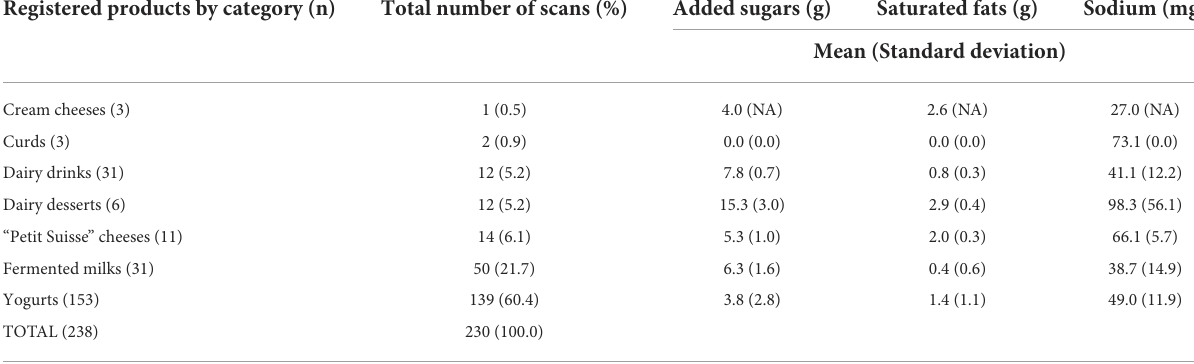
TABLE 3 Number of registered products for the pilot study ( n = 238), number and percentage of scanned products ( n = 230), grouped by category, and mean and SD of the evaluated nutrients (per 100g or